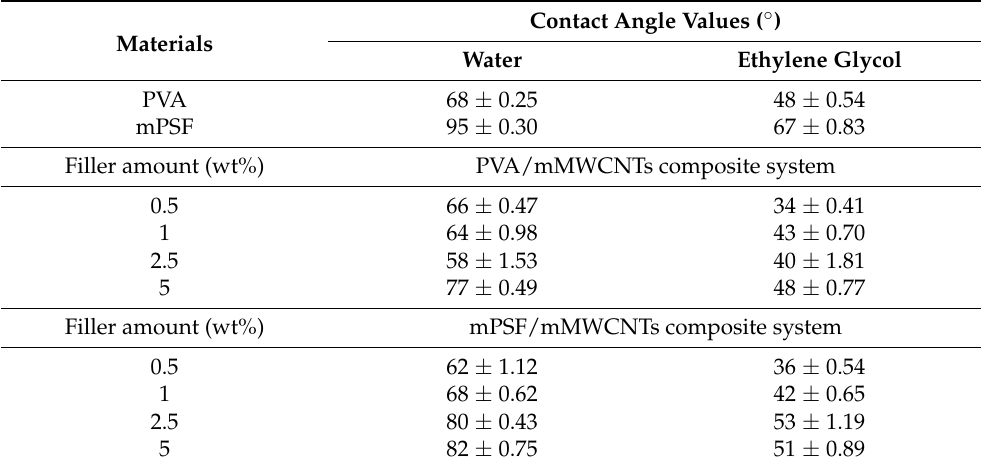
Table 2. The measured values of contact angles ( θ ) for PVA, mPSF, and corresponding mMWCNTs composite